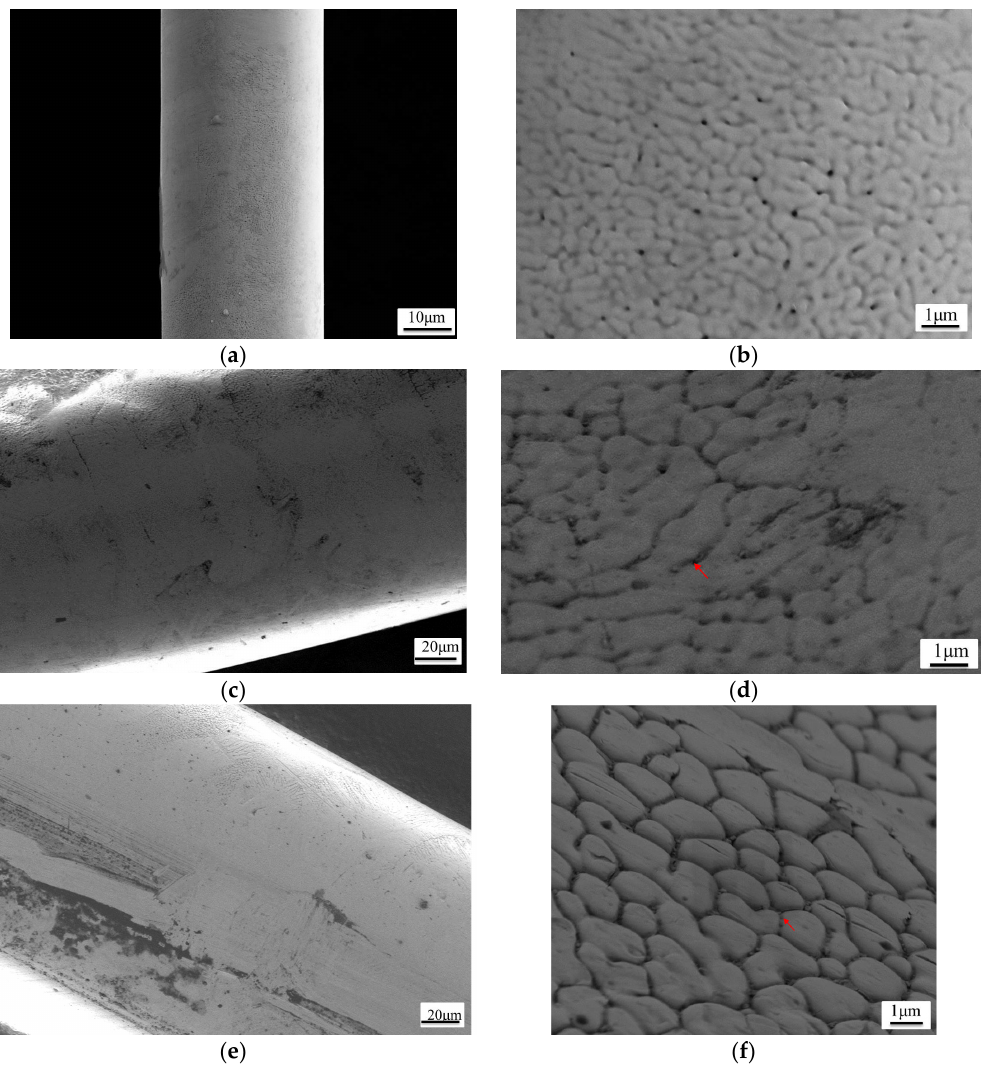
Figure 3. Morphology of surfaces and polished cuts of the fibers. ( a,b ) Ni54.9–Mn23.5–Ga21.6; ( c,d ) Ni55.7–Mn23.3–Ga21.0; ( e,f ) Ni56.6–Mn22.4–Ga21.0.